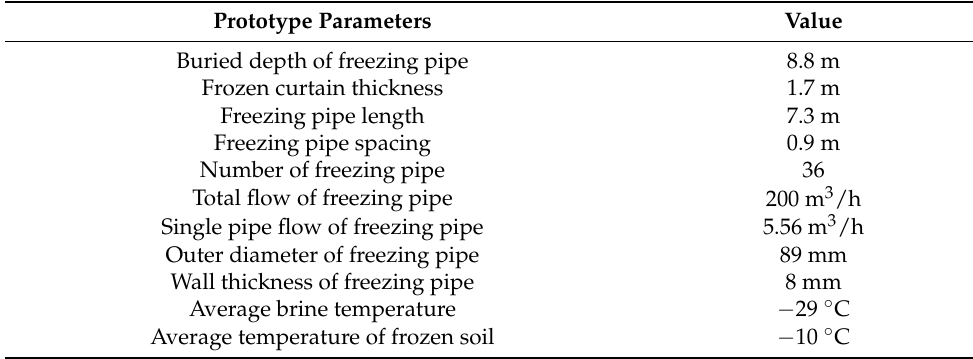
Figure 1. Prototype location and working condition. Table 1. Simplified site construction parameters.